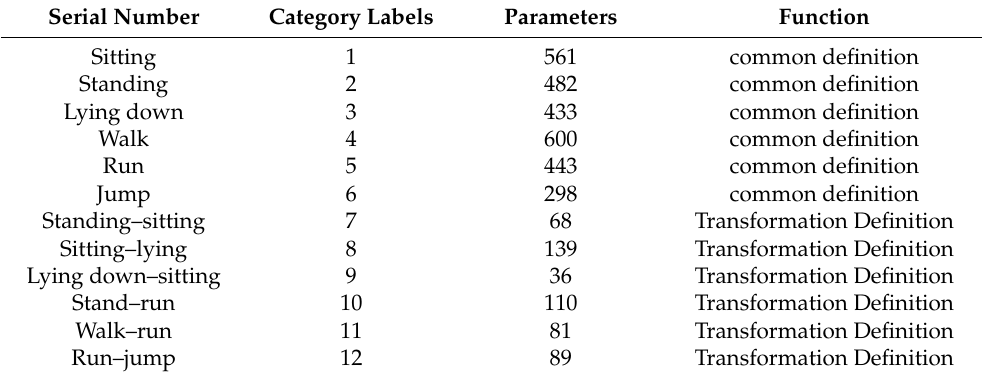
Table 5. HAPT sample data collection